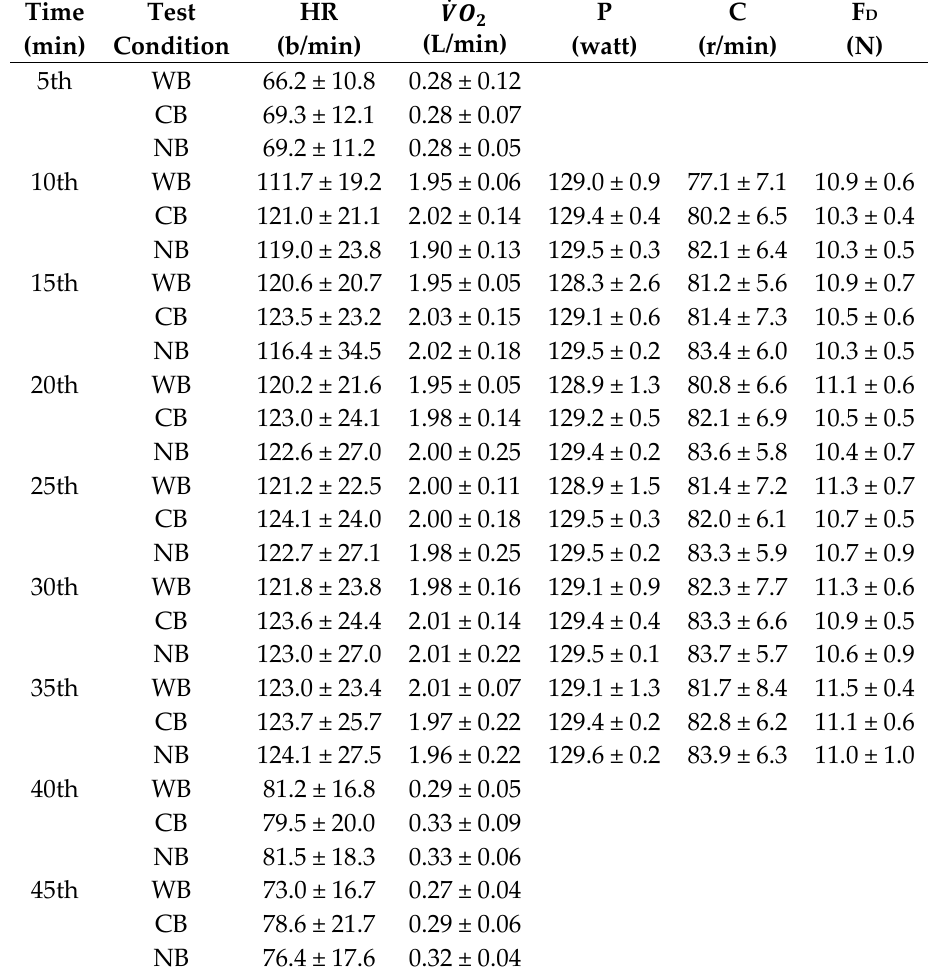
Table 1. Heart rate (HR), oxygen uptake (𝑉(cid:4662) 𝑂 (cid:2870) ) , power (P), cadence (C) and aerodynamic drag (F D ) for the three test conditions at selected time intervals during the test protocol. Mean ±